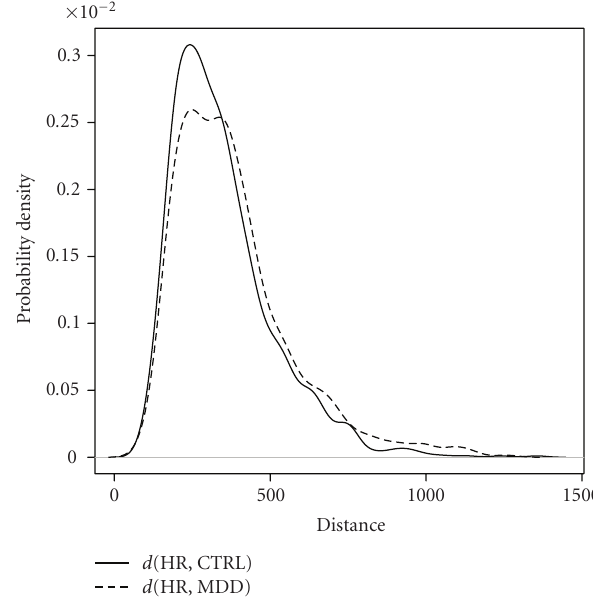
Figure 4: This figure shows kernel probability density estimates for D LM-Left . The solid line depicts d (HR,CTRL) and the dashed line depicts d (HR,MDD).